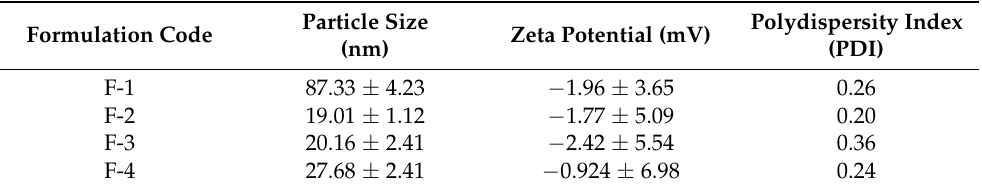
Table 6. Estimation of droplet size, zeta potential and PDI of SEDDS formulations (mean ± SD, n = 3). Formulation